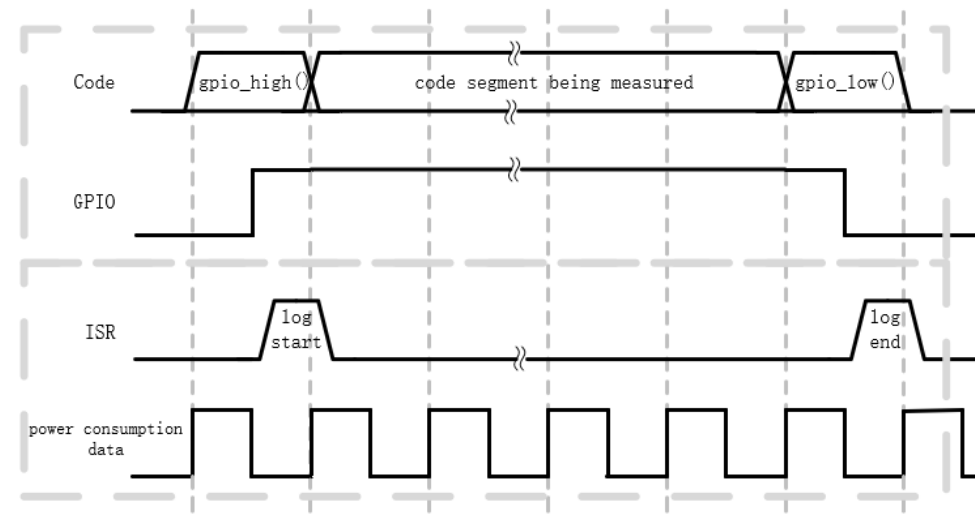
Figure 2. Time sequence of the synchronized power consumption data and timestamp.